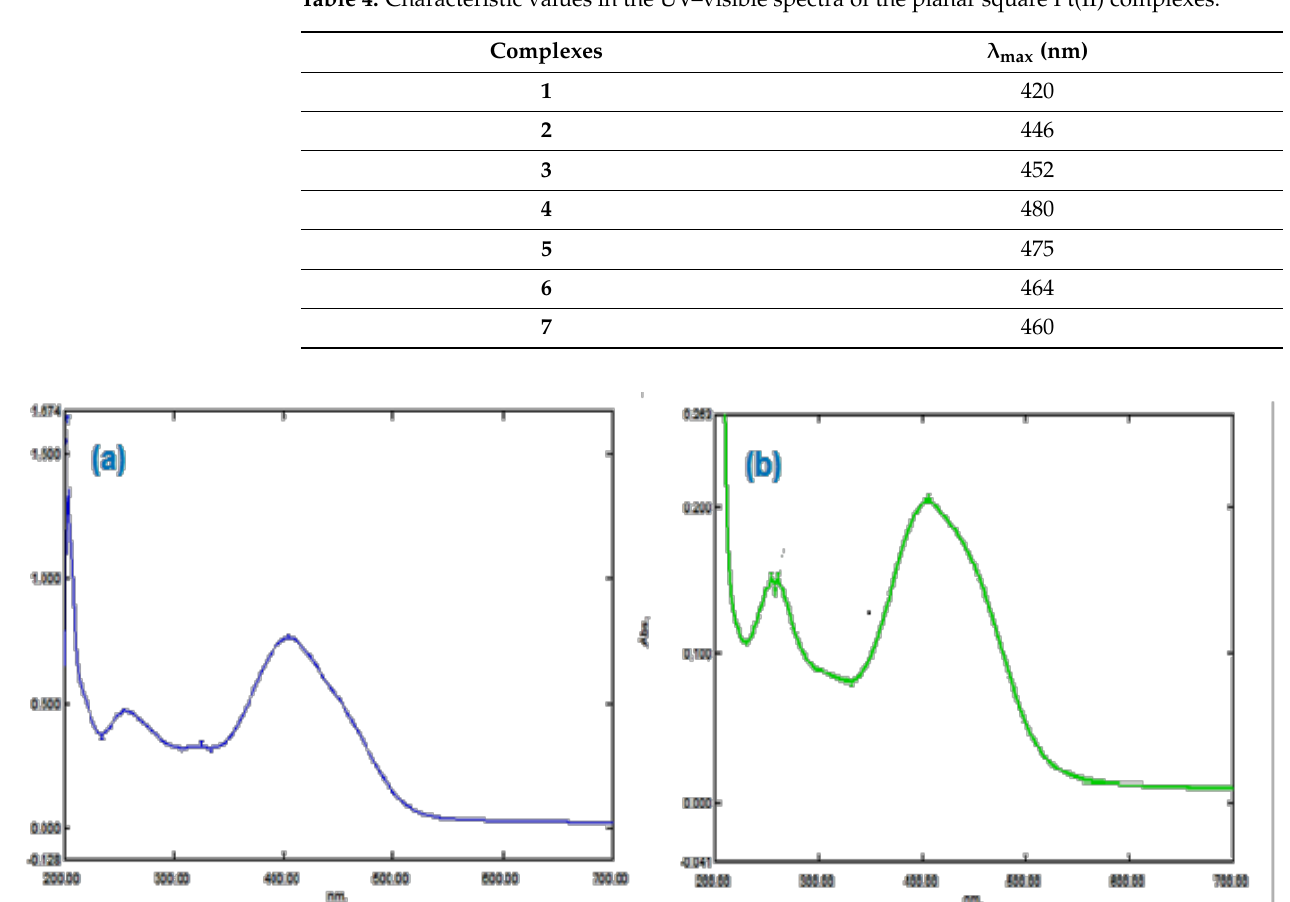
Table 4. Characteristic values in the UV–visible spectra of the planar square Pt(II) complexes.